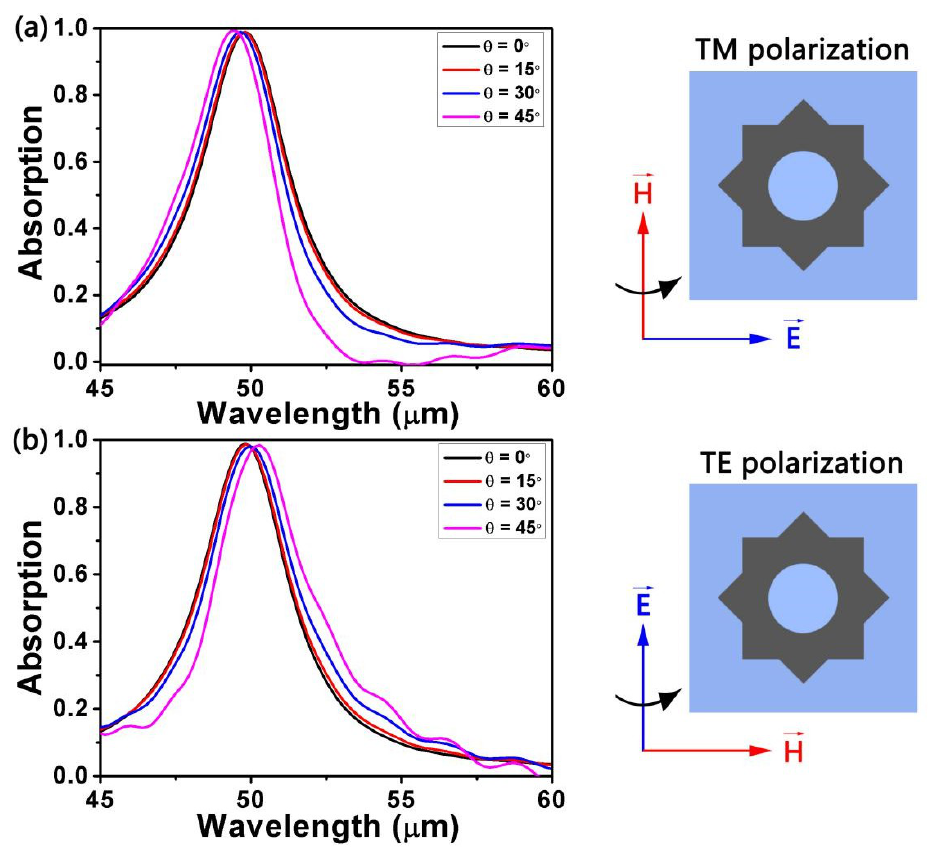
Figure 4. Absorption spectra at different incident angles for ( a ) transverse magnetic (TM)-polarization and ( b ) transverse electric (TE)-polarization.